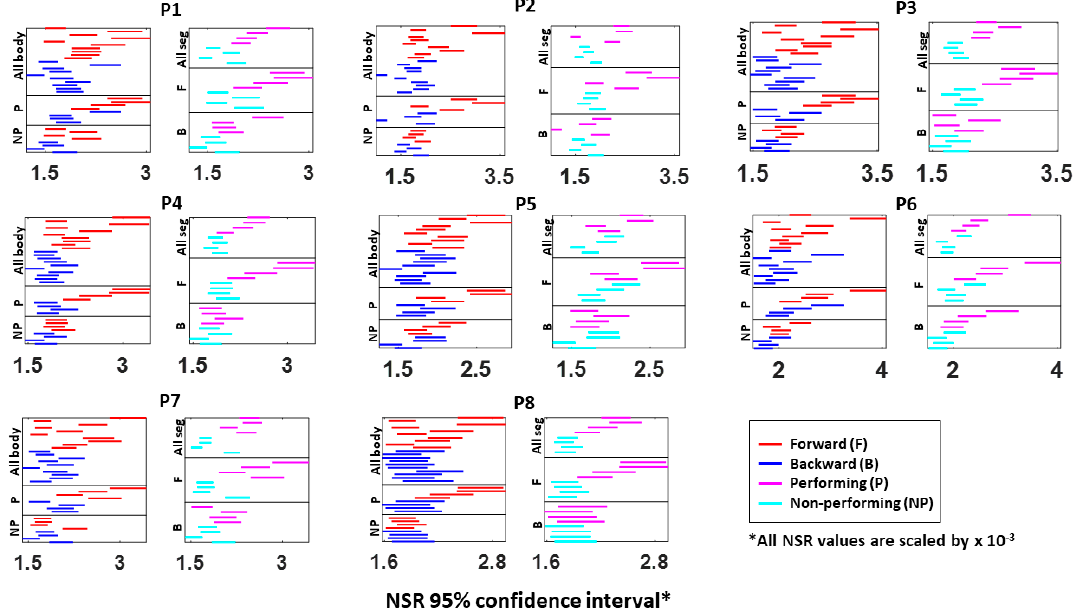
Figure A3. Fitted Gamma scale parameter (i.e., NSR) 95% confidence interval for a single body part’s kinematics data. The 95% confidence interval is plotted for all eight participants (P1 to P8). Each row represents a single body part: under the “All body” category shows all 10 body parts during forward (red) and backward (blue) motions; under the “P (performing)” category shows the 4 body parts from the performing side of the arm; under the “NP (non-performing)” category shows the 4 body parts from the non-performing side of the arm; under the “All seg (all segment)” category shows the 4 body parts on the performing (pink) and non-performing (cyan) side during the entire pointing motion; under the “F (forward)” category shows the 4 body parts on both P and NP side during forward motion; and under the “B (backward)” category shows the 4 body parts on both P and NP side during backward motion.